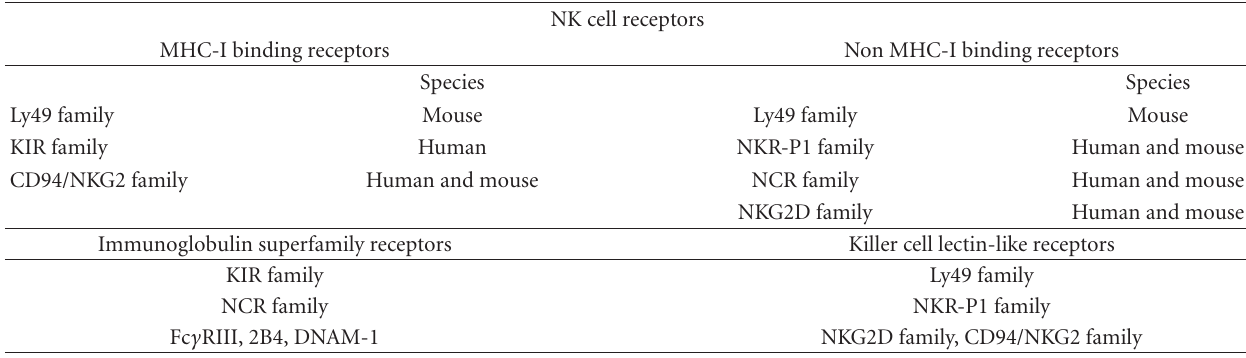
Table 1: NK cell receptors can be divided in two groups based on binding to MHC class I- or non MHC class I molecules as their ligands. NK cell receptors can also be structurally divided in two groups as immunoglobulin superfamily or killer cell lectin-like